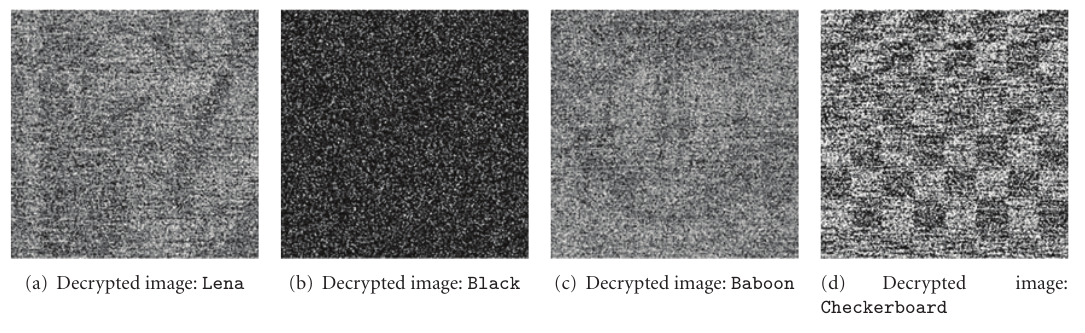
Figure 7: Attack by speckle noise.